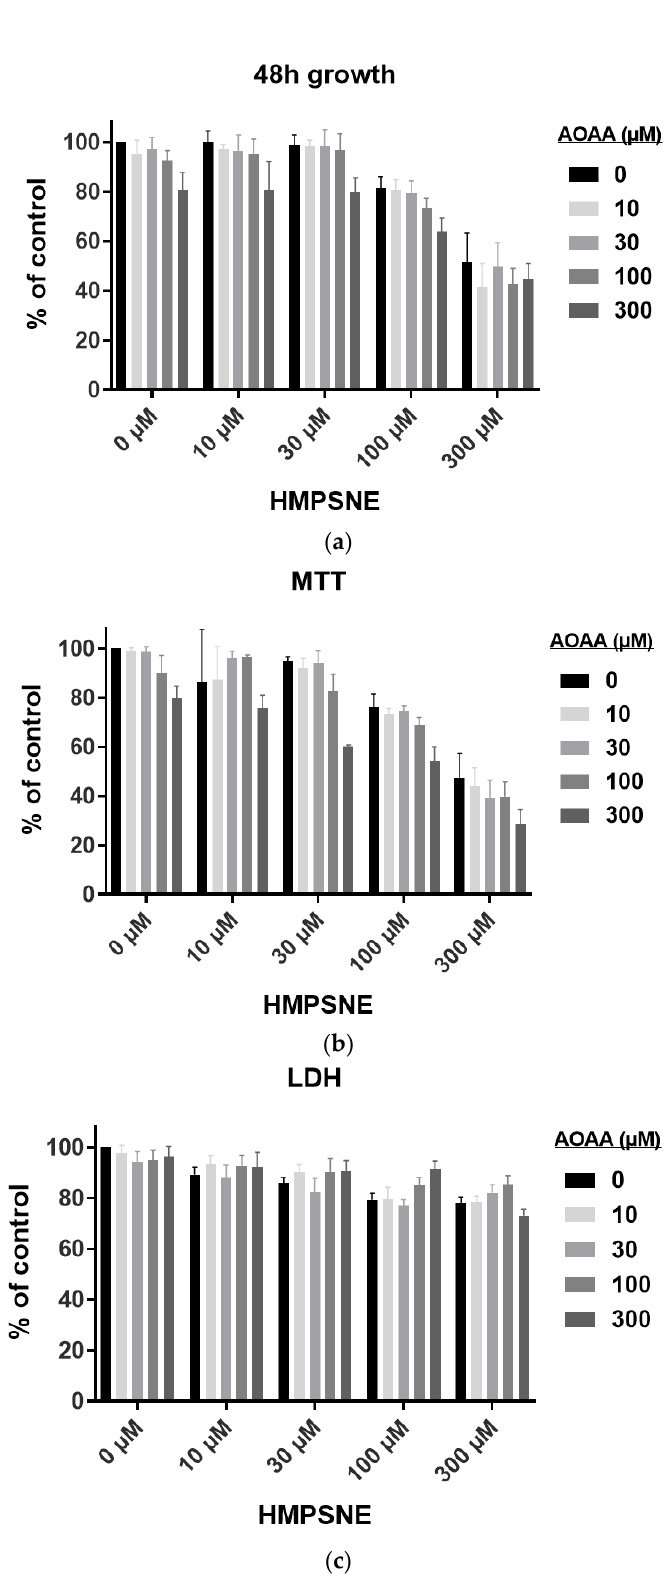
Figure 7. Proliferation, metabolic activity and cell death by necrosis of CT26 incubated with combination of HMPSNE and AOAA: ( a ) Cell confluence after 48 h growth shown as percentage of untreated cells; ( b ) MTT conversion by CT26 cells after 48 h growth shown as percentage of untreated cells; ( c ) lactate dehydrogenase (LDH) activity in medium of CT26 grown for 48 h shown as percentage of untreated cells. All graphs present data from at least four independent experiments.